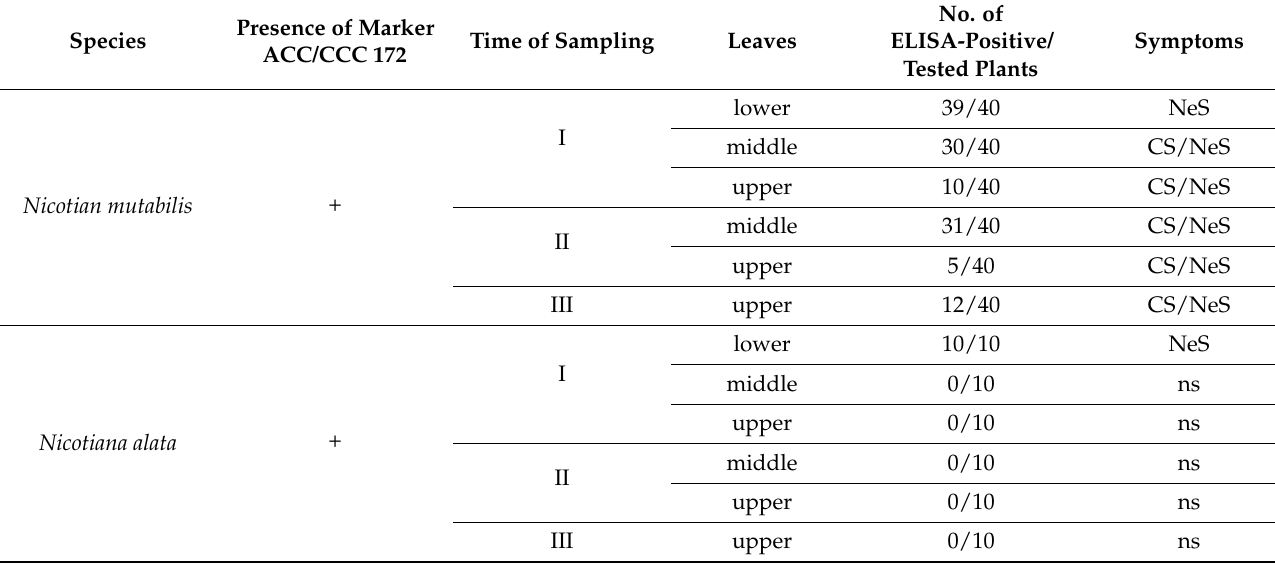
Table 3. Resistance response of the tested species after TSWV inoculation depending on the sam- pling time and the part of the plant.